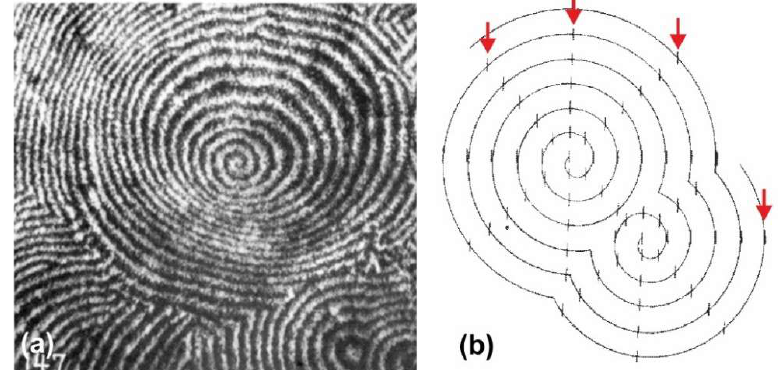
Figure A7. The Wada’s figure showing large scale figures made by arrangement of nacreous tablets ( a ) in which parallel crystal orientations is globally maintained ( b ). Note that looking at the whole-shell level orientation of nacreous tablets follows the morphology of the shell growing edge.